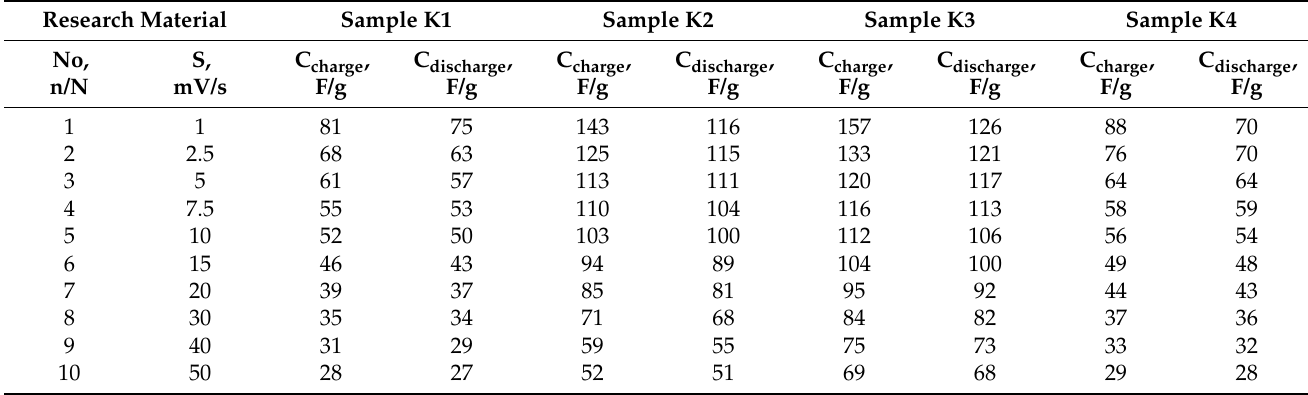
Table 3. The specific capacity of HSCs on synthesized materials obtained from cyclic voltammograms.